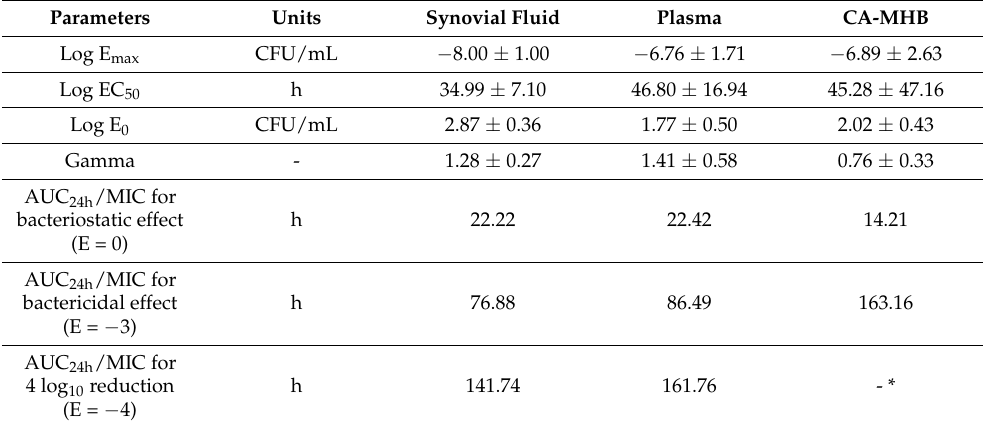
Table 2. PK/PD breakpoints determined from the sigmoidal E max inhibition equation in porcine synovial Fluid, plasma and CA-MHB.